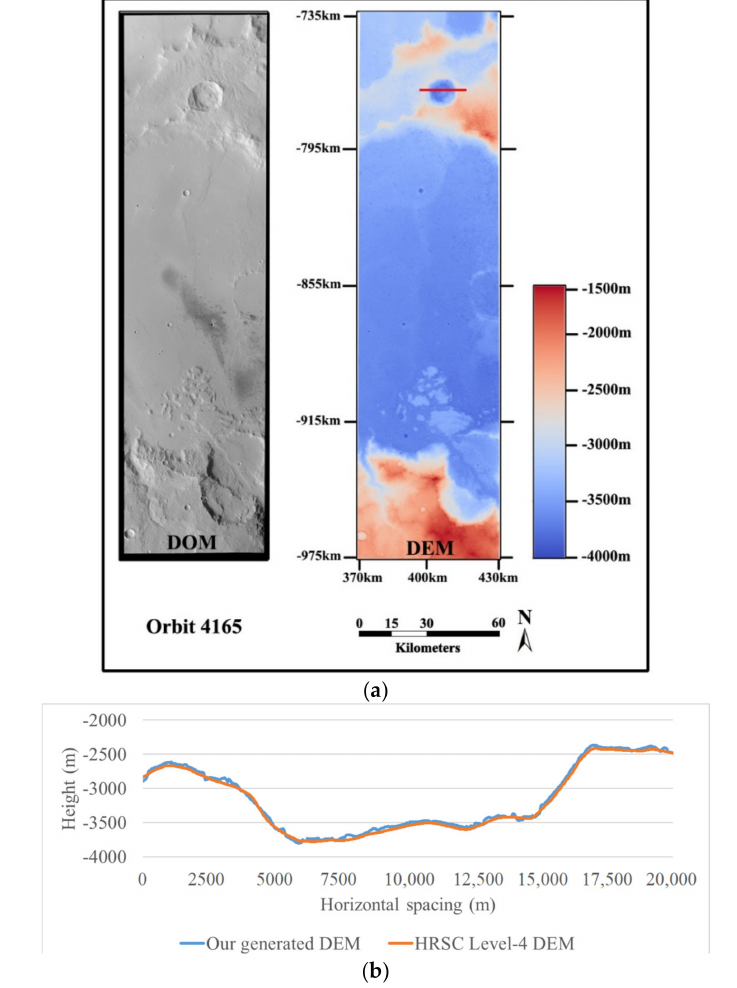
Figure 16. DEM results and terrain profiles comparison for orbit 4165: ( a ) digital orthophoto map (DOM) and DEM results; and ( b ) terrain profiles comparison between the generated DEM and the HRSC Level-4